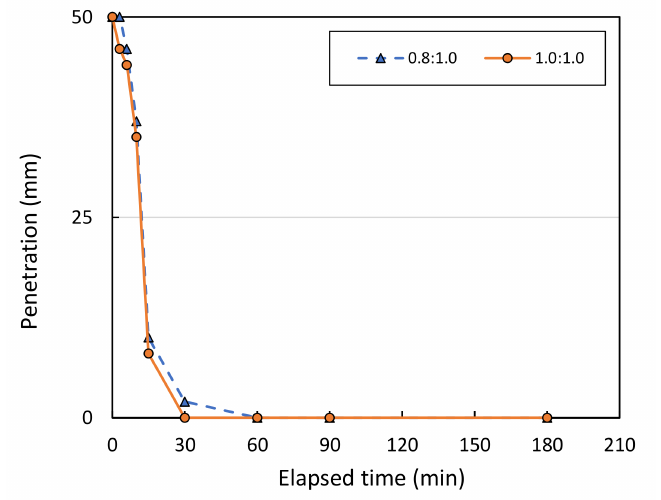
Figure 14. Penetration vs. the elapsed time of Vicat needle testing for metakaolin treated at 1000 ◦ C, using different mixing ratios.